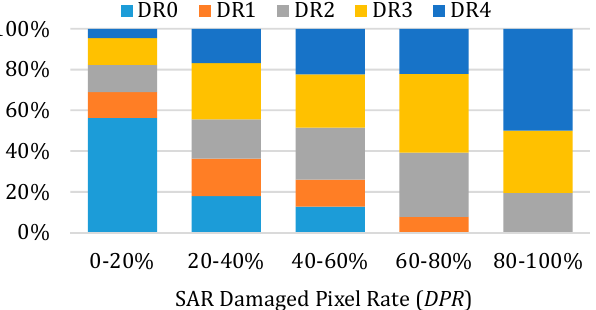
Figure 15. Comparison of SAR-based damaged pixel rate (DPR) and survey-based major damage rate.